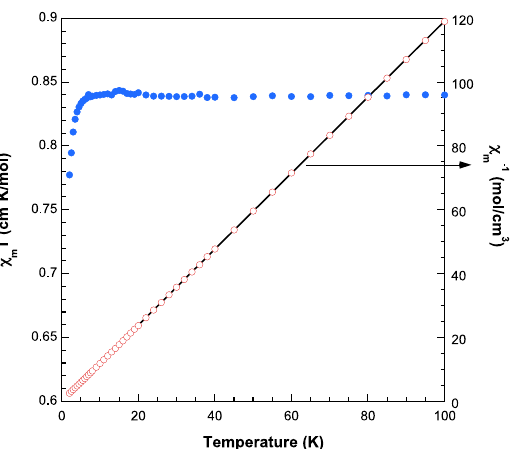
Figure 8 . Magnetic behavior of compound X. The solid line corresponds to the Curie–Weiss fit (see text for the details).